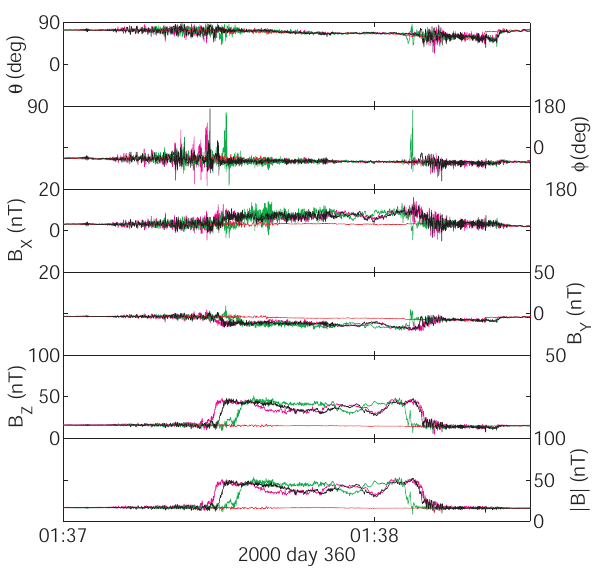
Fig. 11. Ninety seconds of magnetic field data at all four spacecraft. Traces for each spacecraft are shown in a different colour: black, red, green and magenta for spacecraft 1, 2, 3 and 4, respectively. Spacecraft 1, 3 and 4 briefly entered the magnetosheath during this time.